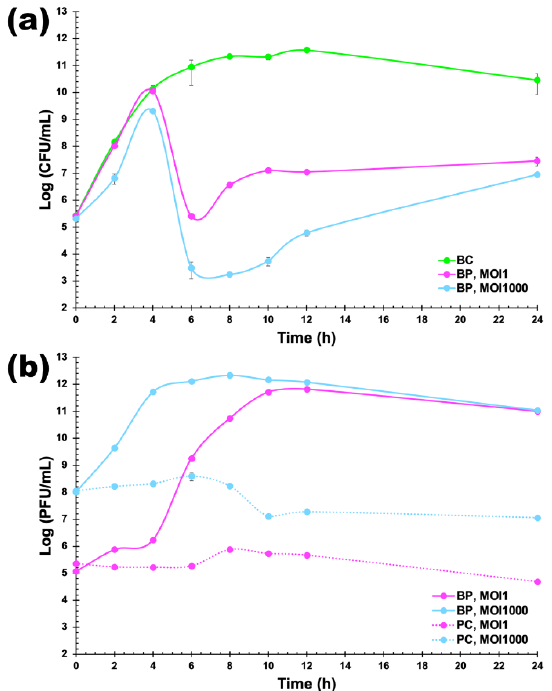
Figure 8. In vitro inactivation of K. pneumoniae by phage Kpn31. ( a ) Inactivation of K. pneumoniae CCCD-K001 was evaluated at a MOI of 1 and of 1000 by determining the bacterial concentration (CFU/mL) ( a ) and phage titre (PFU/mL) ( b ) during 24 h. BC, bacterial control (no phage added); BP, bacteria with phage; PC, phage control. Values represent the mean of three independent assays, whereas error bars represent the standard deviation.